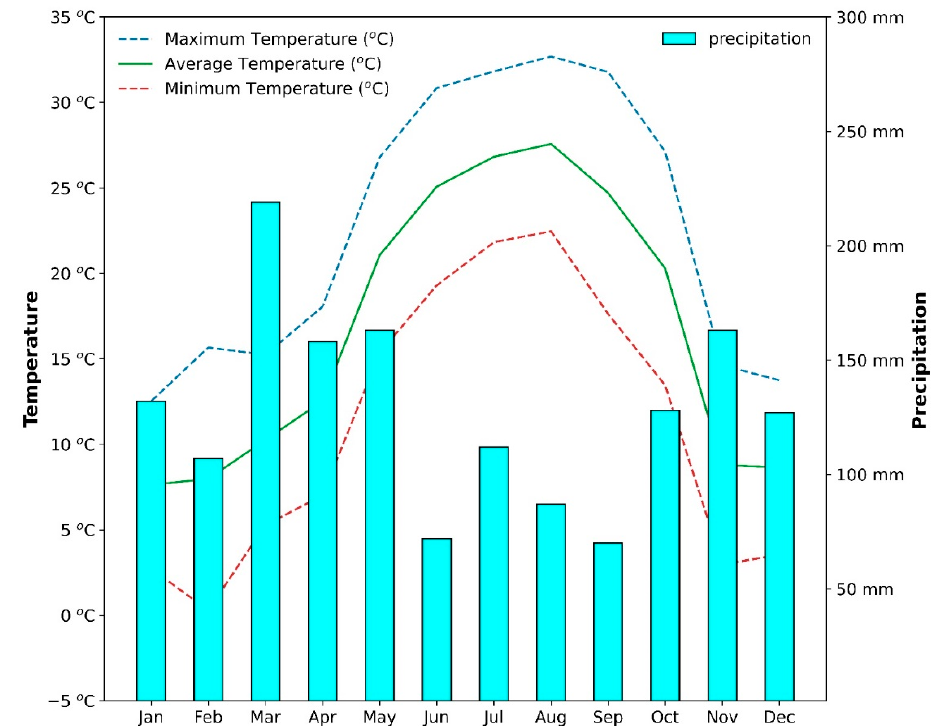
Figure 2. Average monthly minimum, maximum, and average temperature, and precipitation in Big Sunflower River watershed.